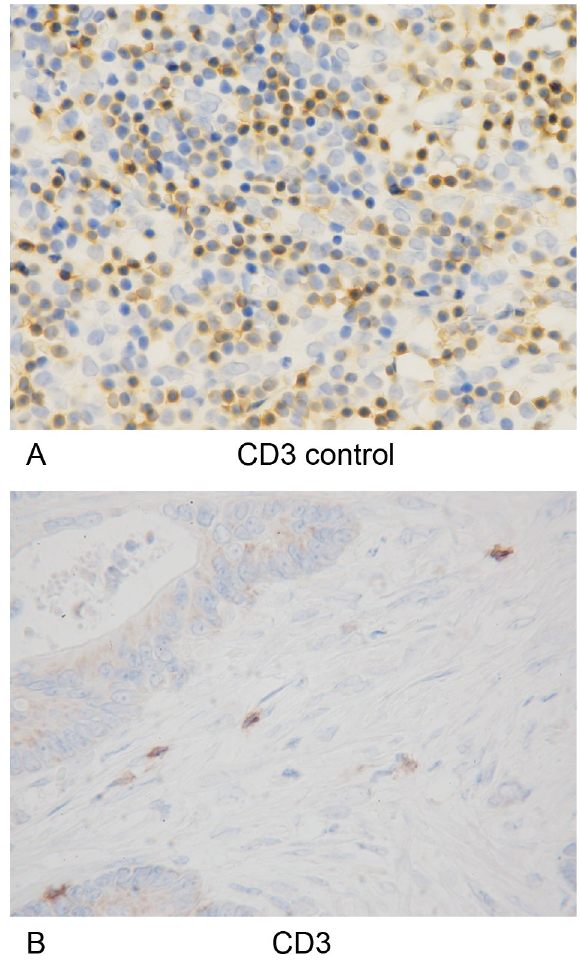
Fig 4. CD3-positive tumor-infiltrating lymphocytes and positive controls. (A) The specimens of lymph nodes containing CD3-positive T lymphocytes were used as positive controls for immunohistochemical staining of anti-CD3 (x400 HPF). (B) Immunohistochemical detection of CD3-positive tumor-infiltrating lymphocytes (x400 HPF).